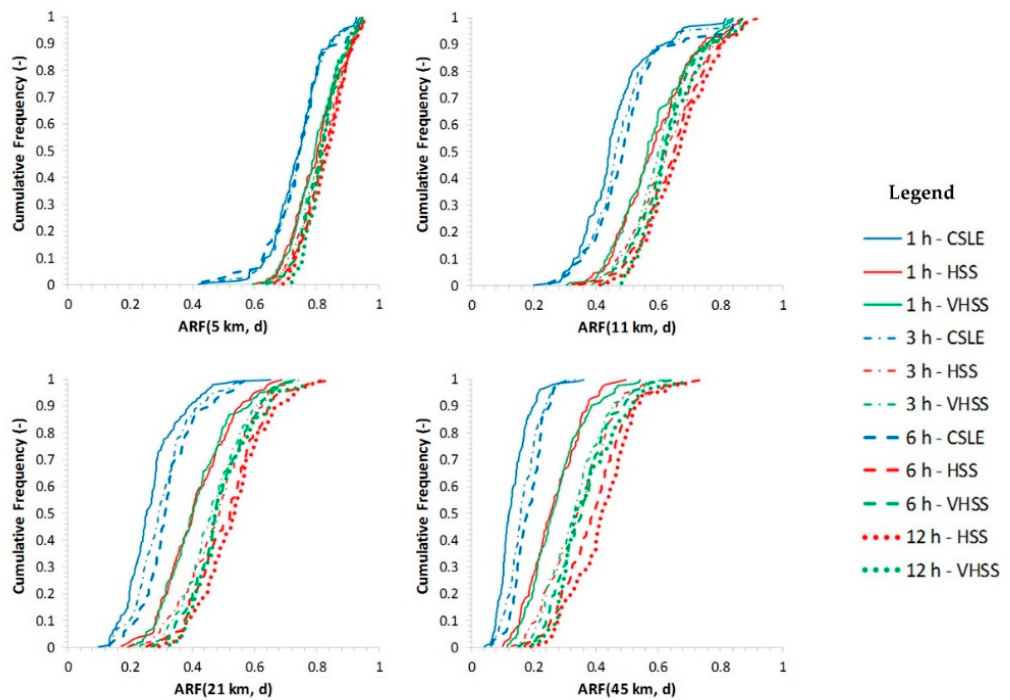
Figure 10. Comparison of cumulative frequency distributions for ARFs, by fixing A and varying d.